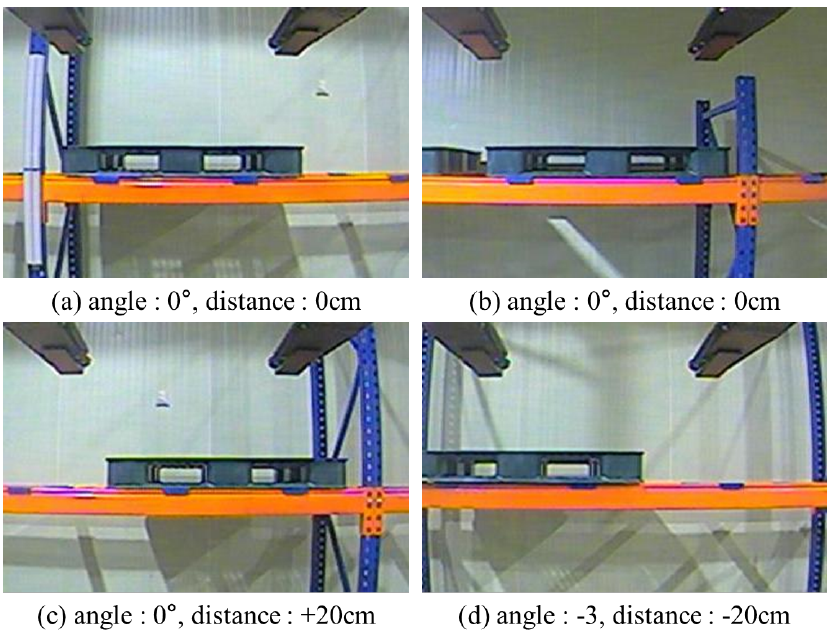
Figure 4. ( a , b ) are correctly placed pallets in different workplaces. ( c ) is an example of a pallet moved 20 cm to the right. ( d ) is an example of a pallet moved 20 cm to the left and rotated three degrees.